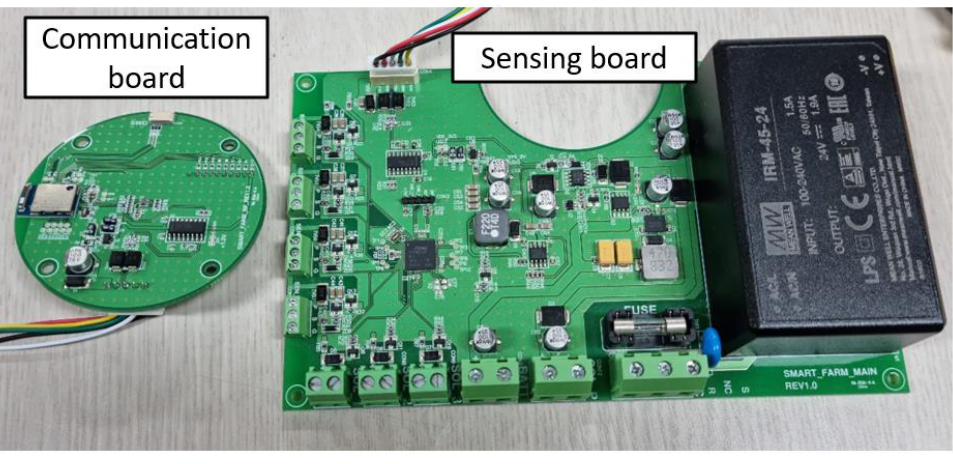
Figure 6. Field Edge Unit boards.